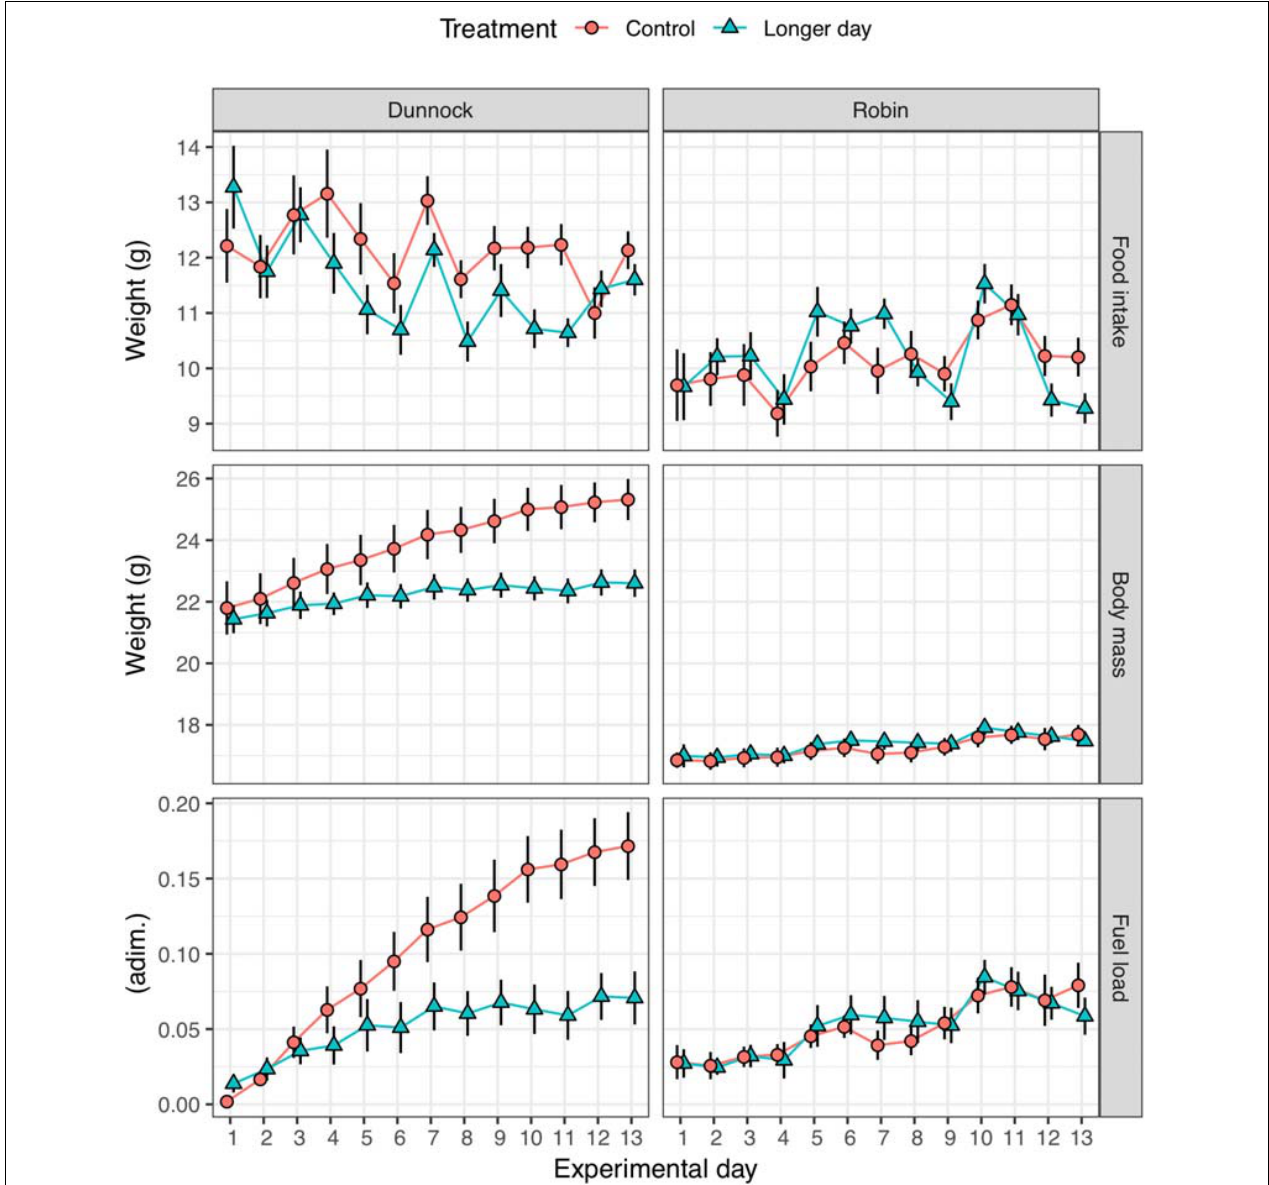
FIGURE 4 | Average ( ± SE) of food intake, body mass and fuel load for first-year migratory dunnocks ( Prunella modularis ) and European robins ( Erithacus rubecula ) monitored under local daylength timing (Control), and 2 h experimentally advanced early sunrise (Longer day) conditions ( n = 12 for each treatment group; n = 24 for each